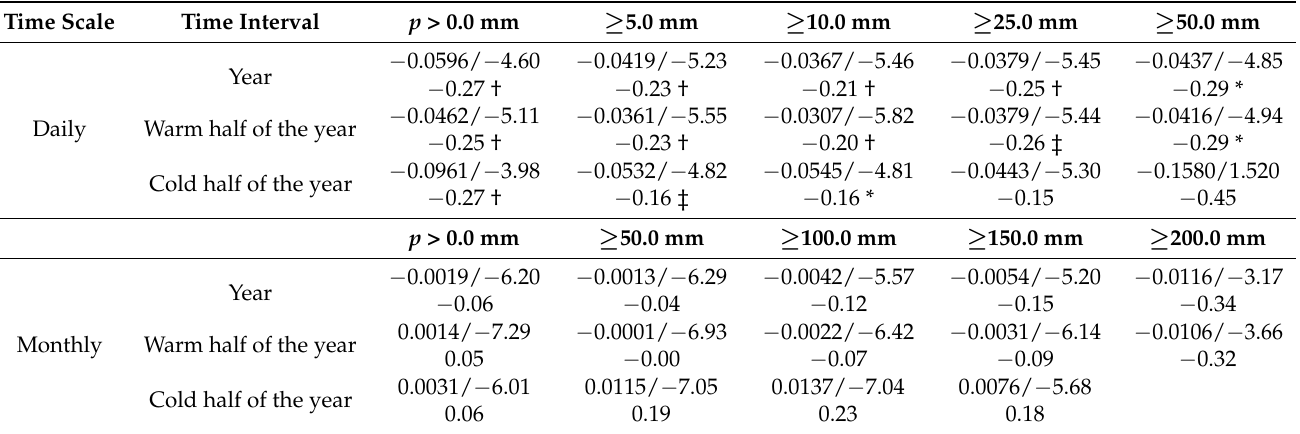
Table 1. Correlations of δ 18 O in precipitation versus precipitation under different precipitation intensities on daily and monthly time scales in